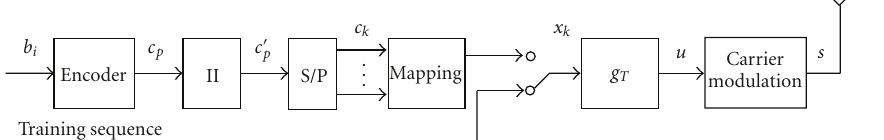
Figure 1: Proposed transmitter structure.